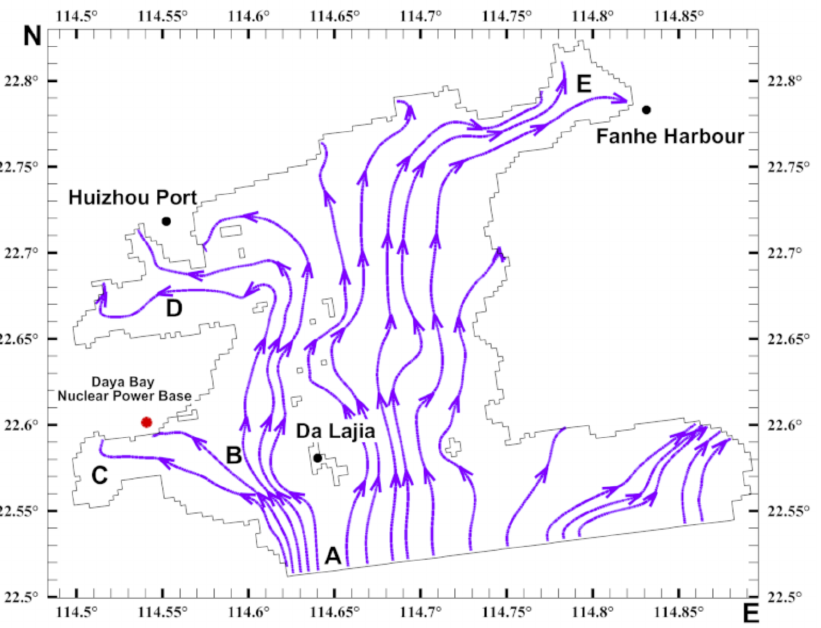
Figure 4. Schematic diagram of inflow